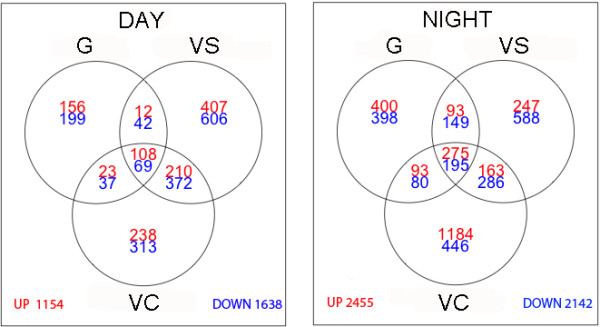
Venn Diagrams of up-or downregulated transcripts (fold change > 2; padj < 0.05) between control and heat stress at the different developmental stages separately (G: Green, VS: VéraisonSugar, VC: VéraisonColor) for DAY (left) and NIGHT (right).